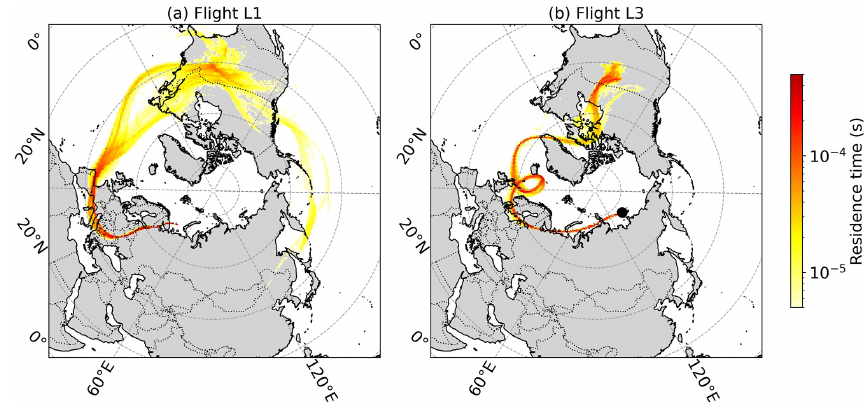
Figure 7. Total column footprints for simulated retro-transport of particles released at 14:53UTC at an altitude of 9324m during flight L1 (a) and at 05:01UTC at an altitude of 5256m during flight L3 (b) . The black dot represents the receptor position.